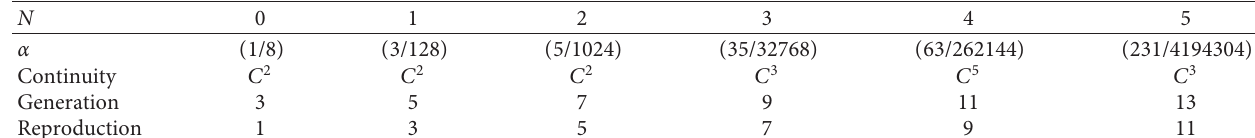
Table 7: Properties of schemes S